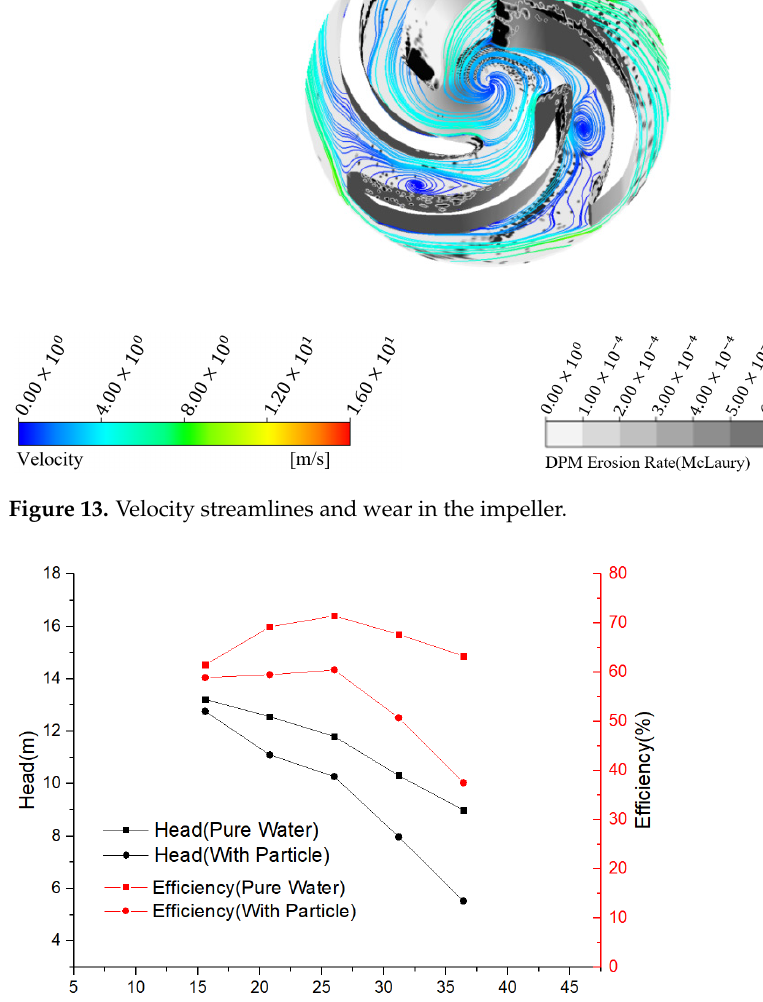
Figure 14. Pump head efficiency under different volume flow rates ( d p = 0.6 mm, C V = 5%).